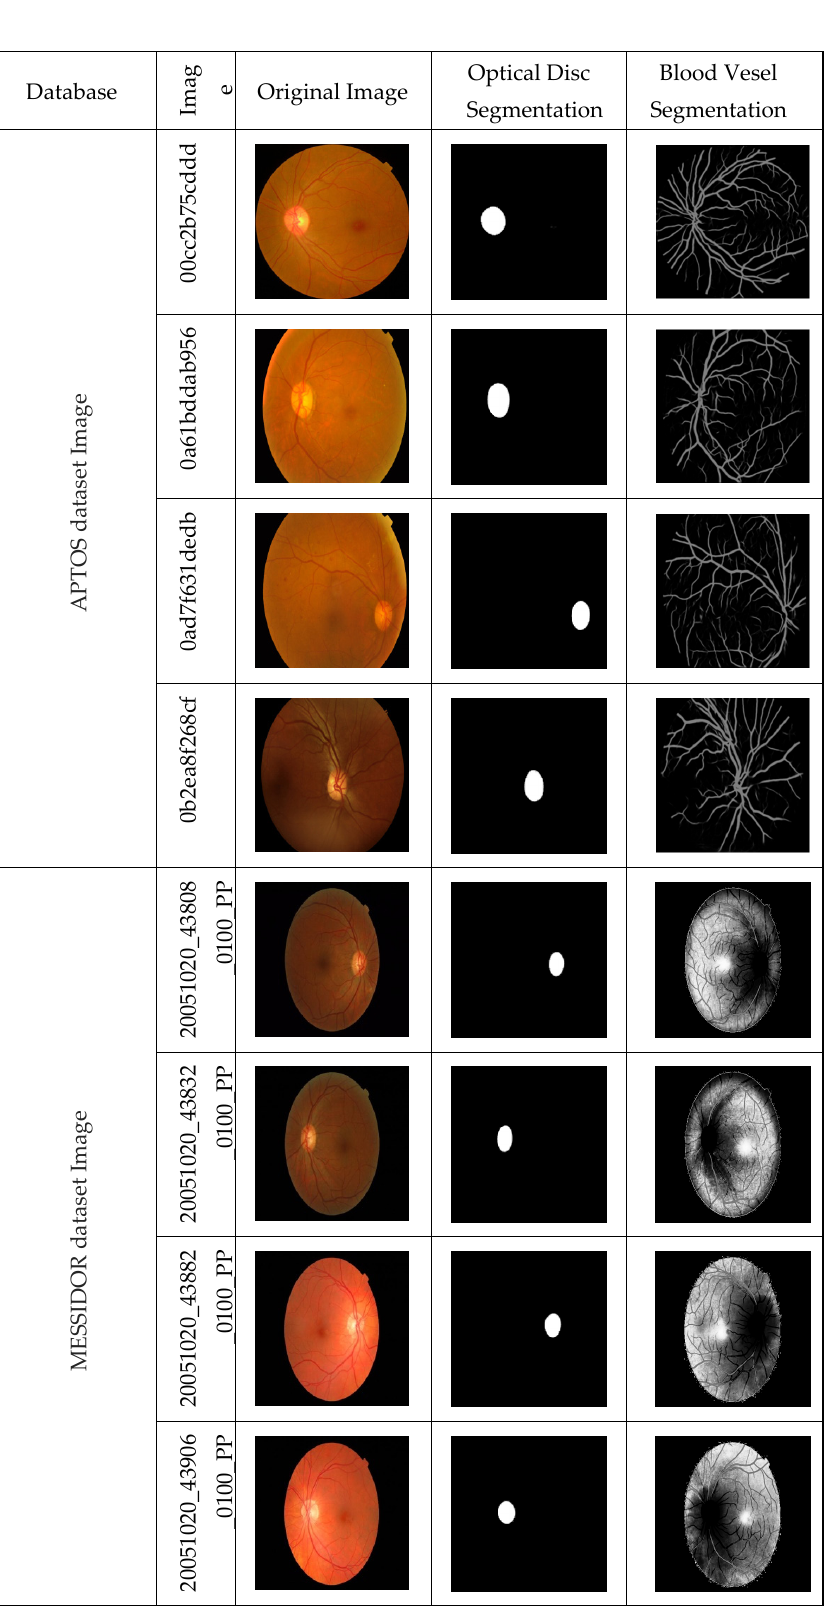
Figure 2. Segmentation of optic disc and blood vessel of the APTOS and MESSIDOR fundus